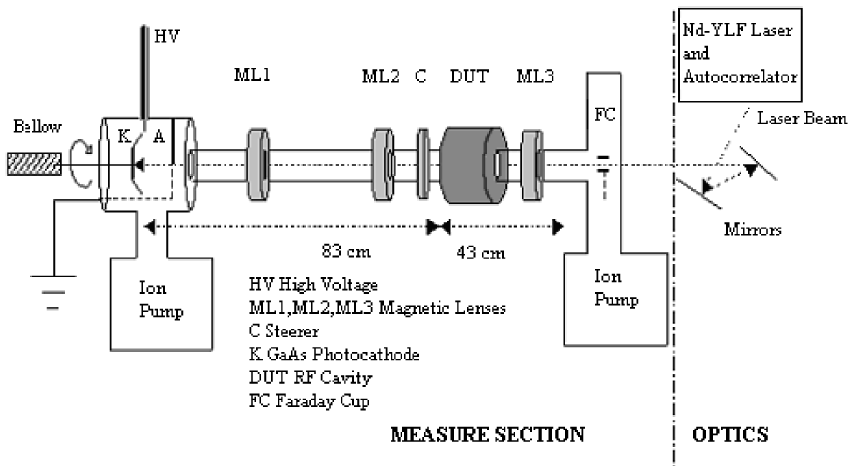
FIG. 1. The experimental setup for the longitudinal loss factor (LLF) measurement.